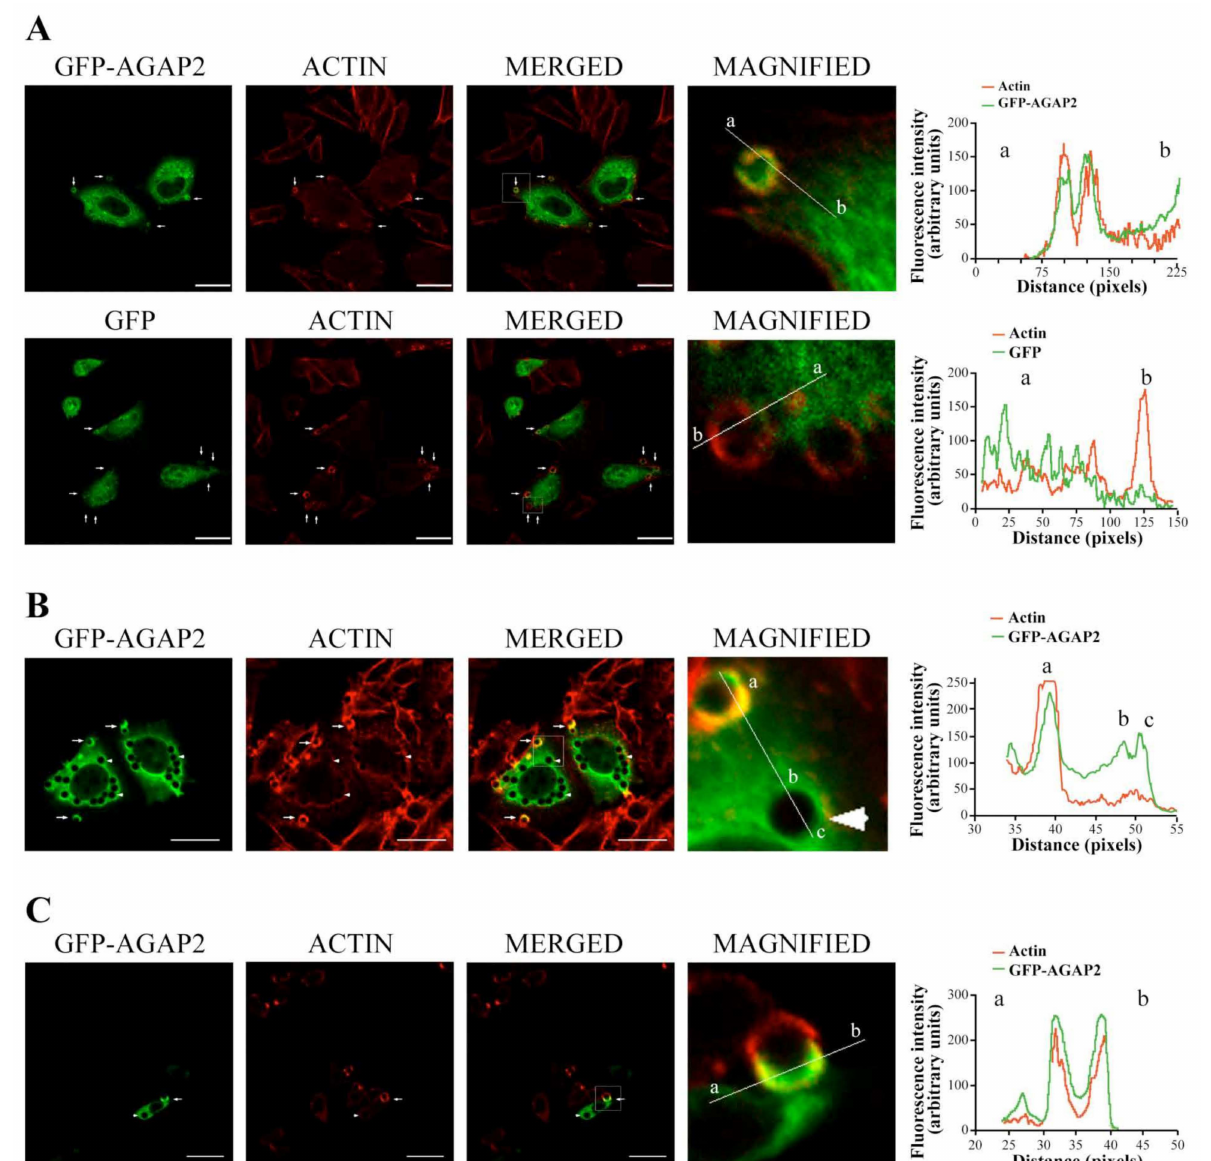
Figure 5. Recruitment of AGAP2 to phagocytic cups. ( A ) CHO-IIA cells transfected with either pEGFP-C1-AGAP2 (upper row) or pEGFP-C1 alone (lower row) were incubated for 1 min at 37 ◦ C with IgG-opsonized beads and stained with Alexa 594-phalloidin (red). Confocal images were acquired. ( B ) CHO-IIA cells transfected with pEGFP-C1-AGAP2 were allowed to undergo phago- cytosis for 30 min. Polymerized actin was labeled with Alexa 594-phalloidin (red). ( C ) RAW264.7 macrophages stably expressing mCherry-actin (red) and transfected with pEGFP-C1AGAP2 were allowed to internalize 3.87 µ m latex beads for 2 min. Arrows and arrowheads show phagocytic cups and sealed phagosomes, respectively. Magnified images of phagocytic cups and/or sealed phagosomes from a frame indicated in each overlay panel are shown. The intensity of each fluo- rescent signal on a solid line is shown in the graphs. Bars, 20 µ m. ( a – c ) Reference points of the image